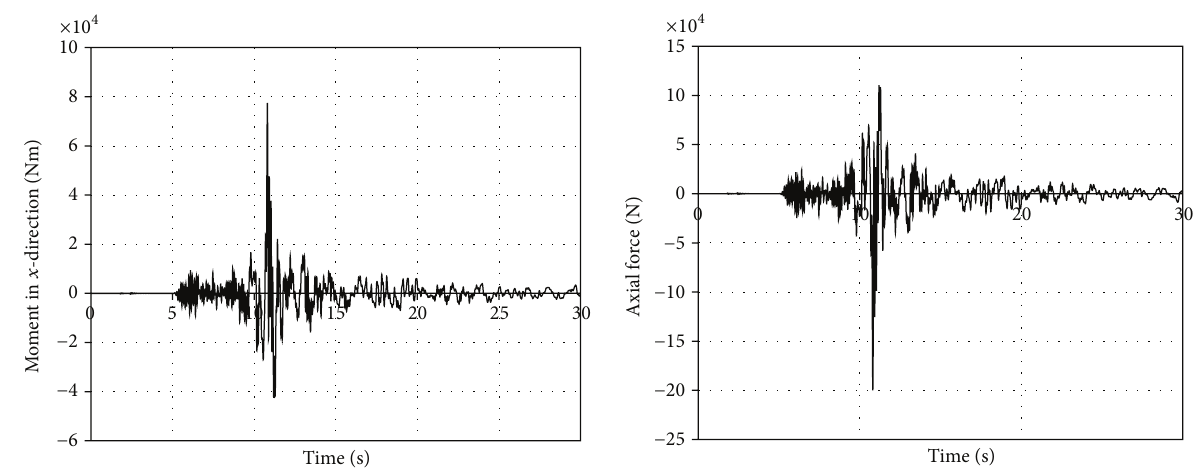
Figure 9: Moment and axial force time histories of the